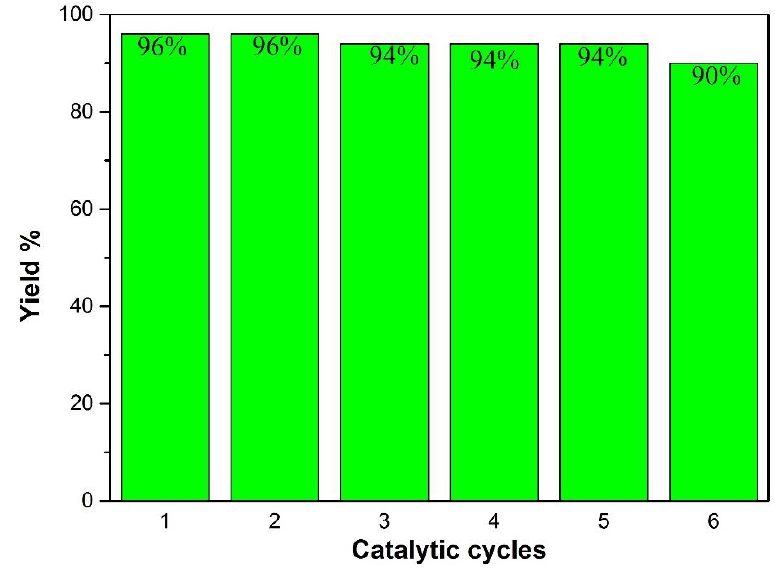
Figure 6. Recyclability of the Ag 2 O/ZrO 2 catalyst.